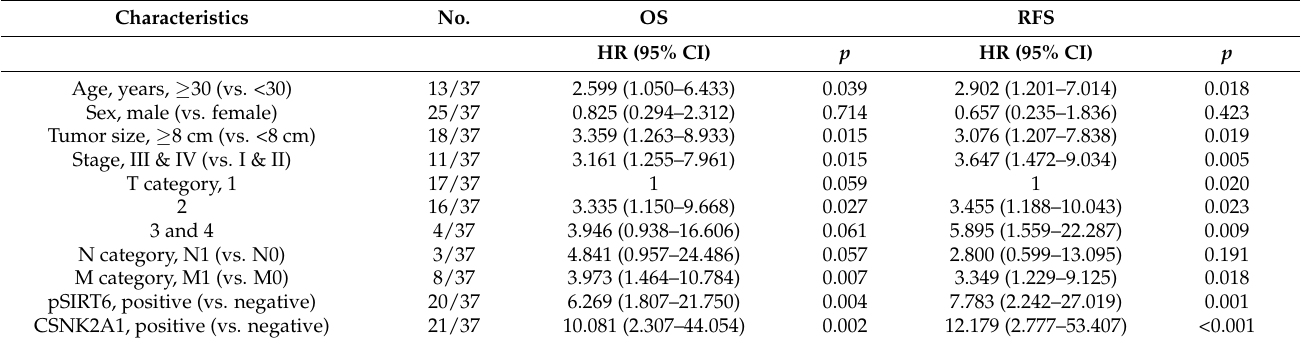
Table 2. Univariate analysis with Cox proportional hazards regression analysis for the survival of 37 osteosarcoma patients. Characteristics